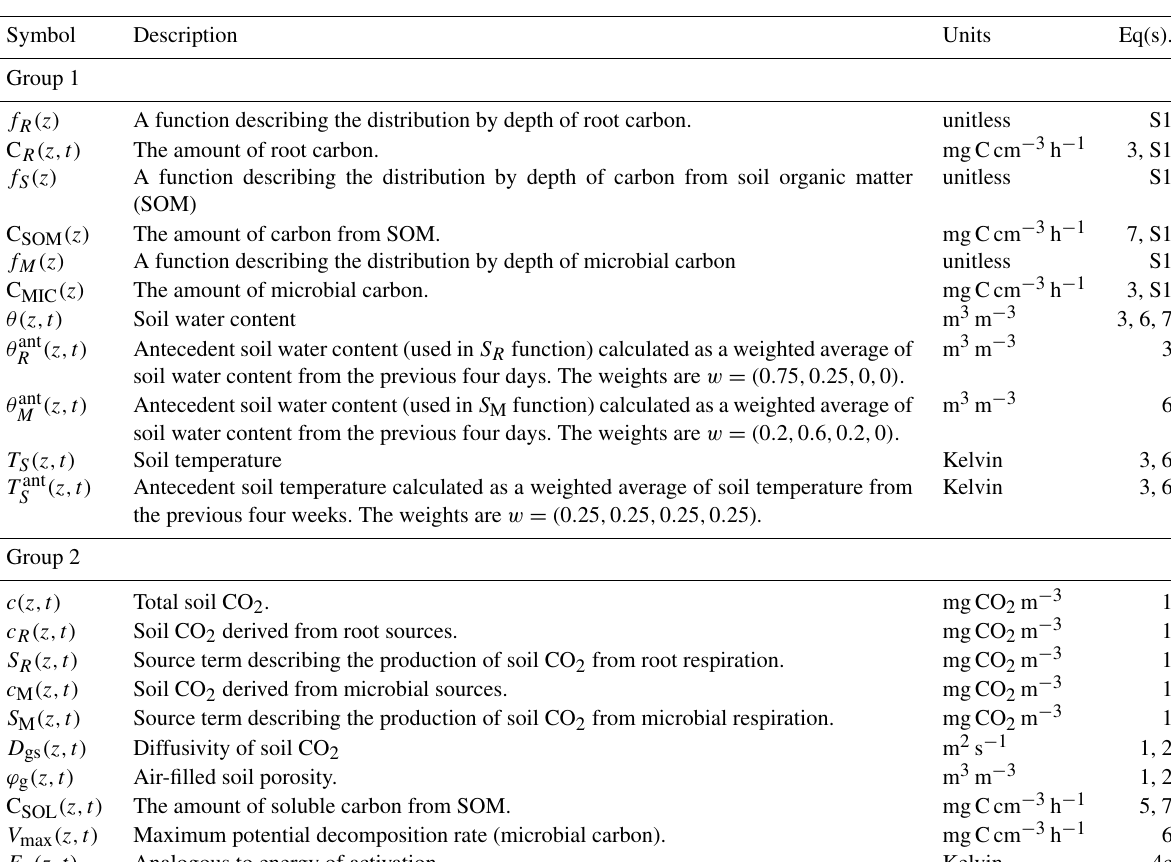
Table 2. Summary of quantities in the non-steady-state (DETECT) model that vary by depth only ( z) , or by depth ( z) and time ( t) . Those in group 1 represent input variables (derived prior to the running of the DETECT model), while group 2 contains the modeled quantities (used as part of the operation of the DETECT model). Equation (S1) can be found in Sect. S1 in the Supplement.